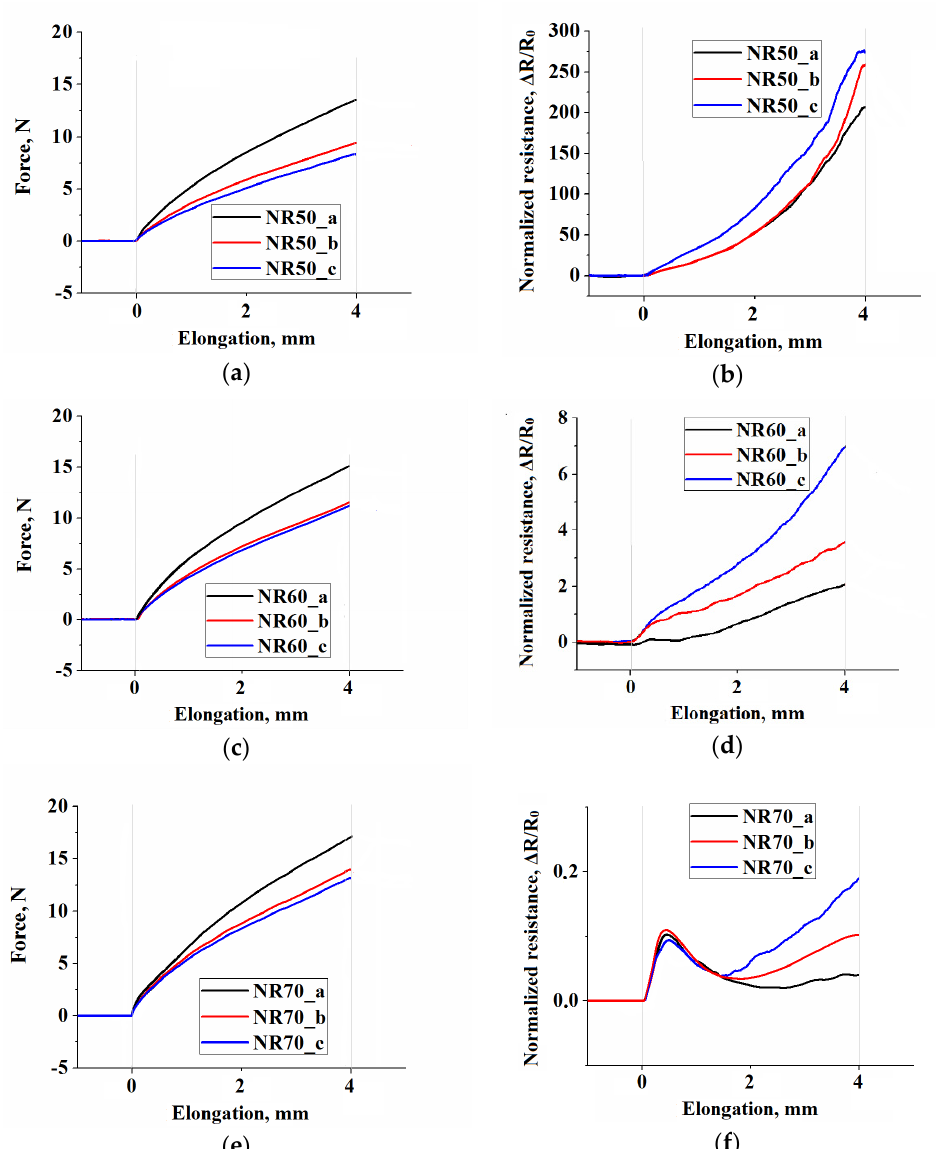
Figure 6. ( a , c , e ) force registered during the testing protocol; ( b , d , f ) electrical resistance of samples. The two samples containing different positions of geometrical inhomogeneity, alt- hough having the same total initial cross-sectional area in the horizontal axis, revealed a difference in the measured force under a certain strain over the complete straining pro- cess. The forces developed by tensile machine to achieve the maximum set strain are de- picted in Figure 7. The sample type b possessing an undivided cross-section area exhibited higher force if compare to sample type c having a divided one. The cause of observed difference was the variation in the location of produced inhomogeneity, resulting in a dif- ferent new surface area creation, preserving the same total cross-sectional area of the two different samples. Therefore, the sample with bulk cross-section area (type b) required more energy to be deformed compared to the divided one (type c) due to an excess in the number of internal molecular bonds. Figure 7. Force at maximum set elongation in strained samples.